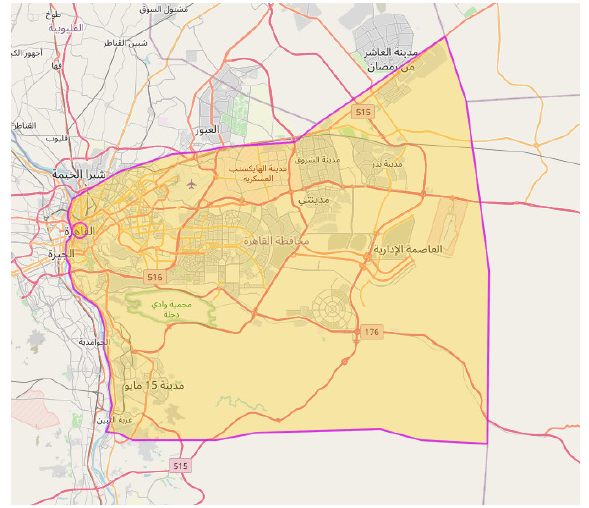
Figure 1. Cairo, one of the five study sites of this